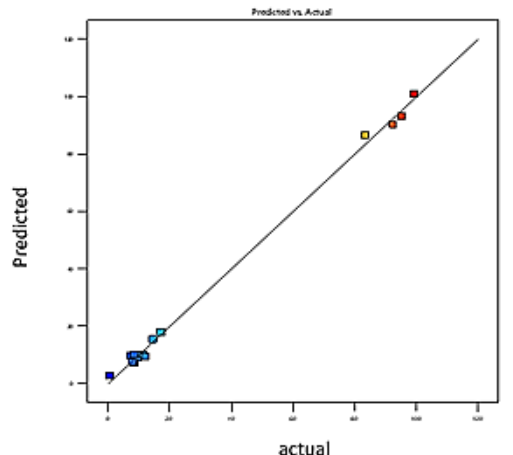
Figure 2. Plot of predicted value vs. observed value for BA retention efficiencies. Y Predicted ; p < 0.0001; R 2 adjusted =0.99; R 2 predicted = 0.9. Values of R 2 higher than 90% indicate a good fit between experimental values with those obtained by the models. The results obtained confirm that the actual values are very close to the predicted values (0.96 and 0.99). Mean values of 6.3 and 3.8 ( p > 0.05) were obtained for the lack-of-fit test, suggesting that the model is reliable in predicting the re- sponse and that it can predict variations within the response [37]. Figures 1 and 2 confirm that the curve of observed values as a function of predicted values perfectly fits the shape of a straight line; we note the close agreement that exists between the experimental results and the theoretical values predicted by the polynomial model [40 – 44]. 3.3. Analysis of Significant Factors The statistical significance of each term (linear, interaction, and quadratic) has been reported in Table 4 obtained from the analysis of variance. Each of the three terms can be considered for the second-order fit. The F -value of models of the first-order, two-way in- teractions, and pure quadratic, indicate that the models were significant at p < 0.05 for the percolation response of both acids. The lack-of-fit values, 3.8 and 6.3 associated with p- values of 0.21 and 0.14, were not significant due to the relative pure error. The results of the present study show that the model is significant with p < 0.05, and by this, the validity of the model is confirmed. Therefore, this model could work for percolation optimization. A summary of significant factors ( p < 0.05) and their effect on the response variable are shown in Table 4. The results obtained show that the volume and pH have a significant influence ( p < 0.0001 and p = 0.0115) on the retention yield. However, no effect was rec- orded for the flow rate ( p > 0.05). The sample volume (X 1 ) played a primary role in im- proving percolation efficiency. Our results agree with other studies [38,42,45]. Overall, the statistical analysis suggests that the experimental values fit the models well, with good accuracy and reliability. Table 4. ANOVA analysis of the percolation step. Source